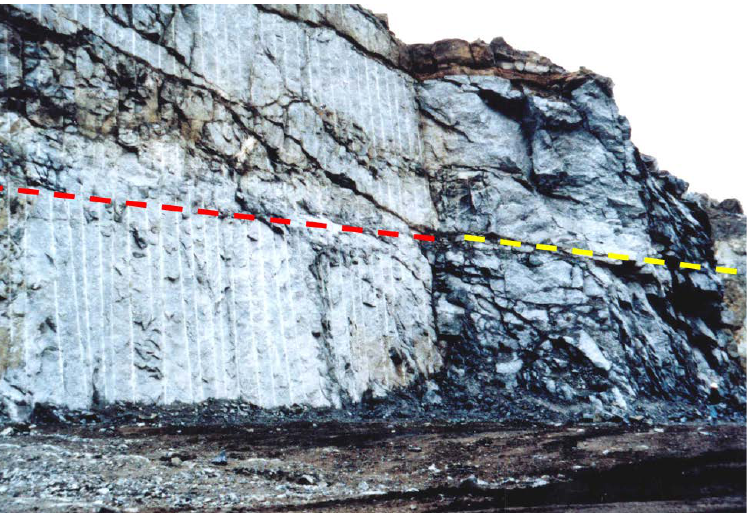
Figure 8. Comparison between the results achieved with presplitting blasting (left—red dashed line) and normal blasting (right—yellow dashed line) for a surface excavation [9]. If the parallelism of the holes, the correct spacing, and a good decoupling between the diameter of the holes and that of the pre-existing